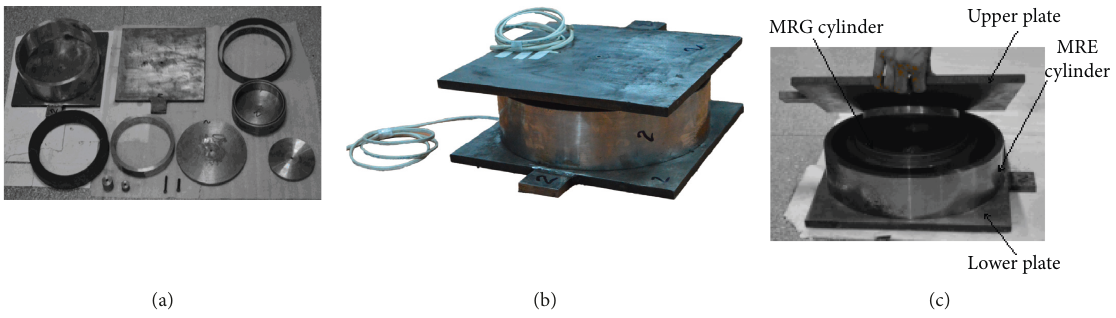
F IGURE 11: Photographs of main parts and MRG/MRE